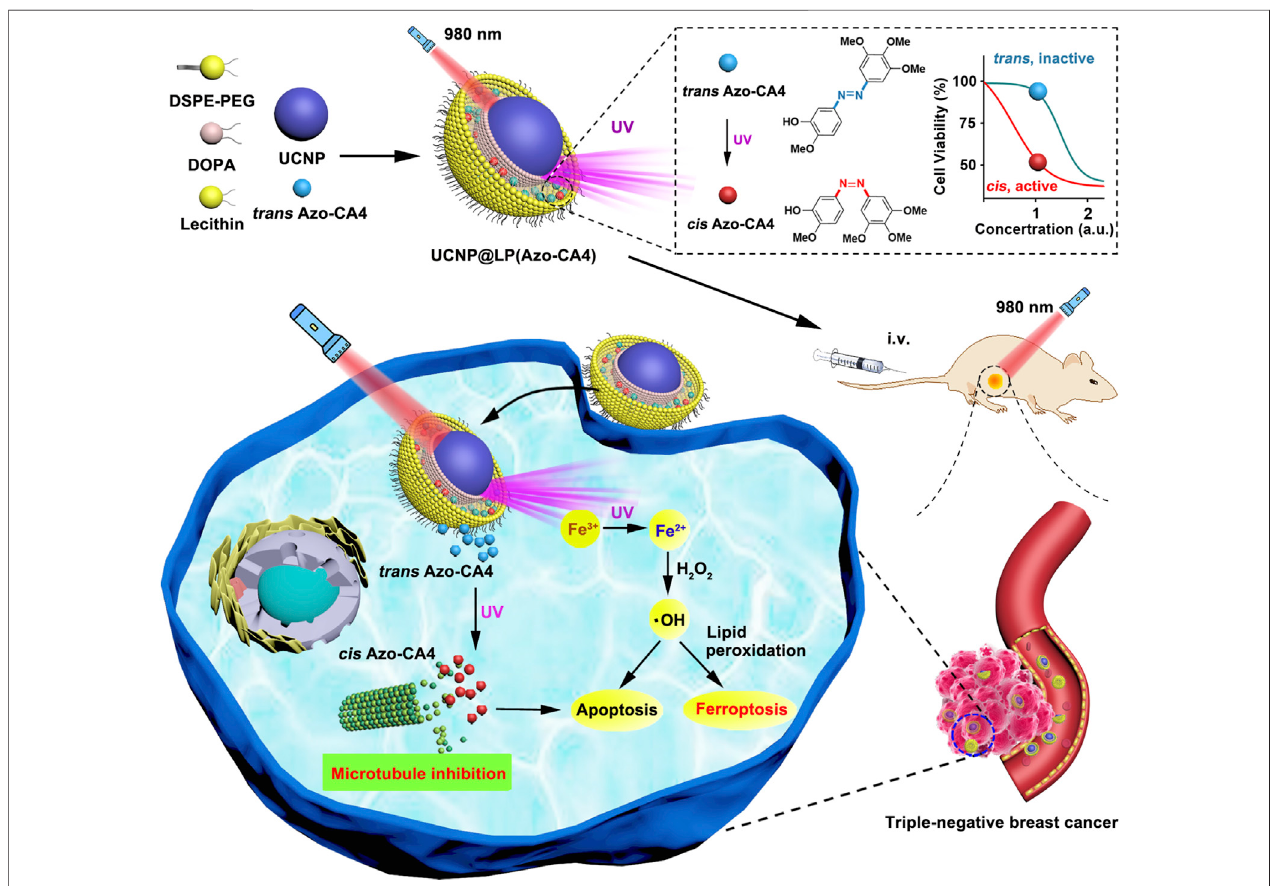
FIGURE 15 | Synthesis scheme and mechanism of UCNP@LP (Azo-CA4). Adapted from Zhu et al., (2020) Copyright @ 2020 (ACS).